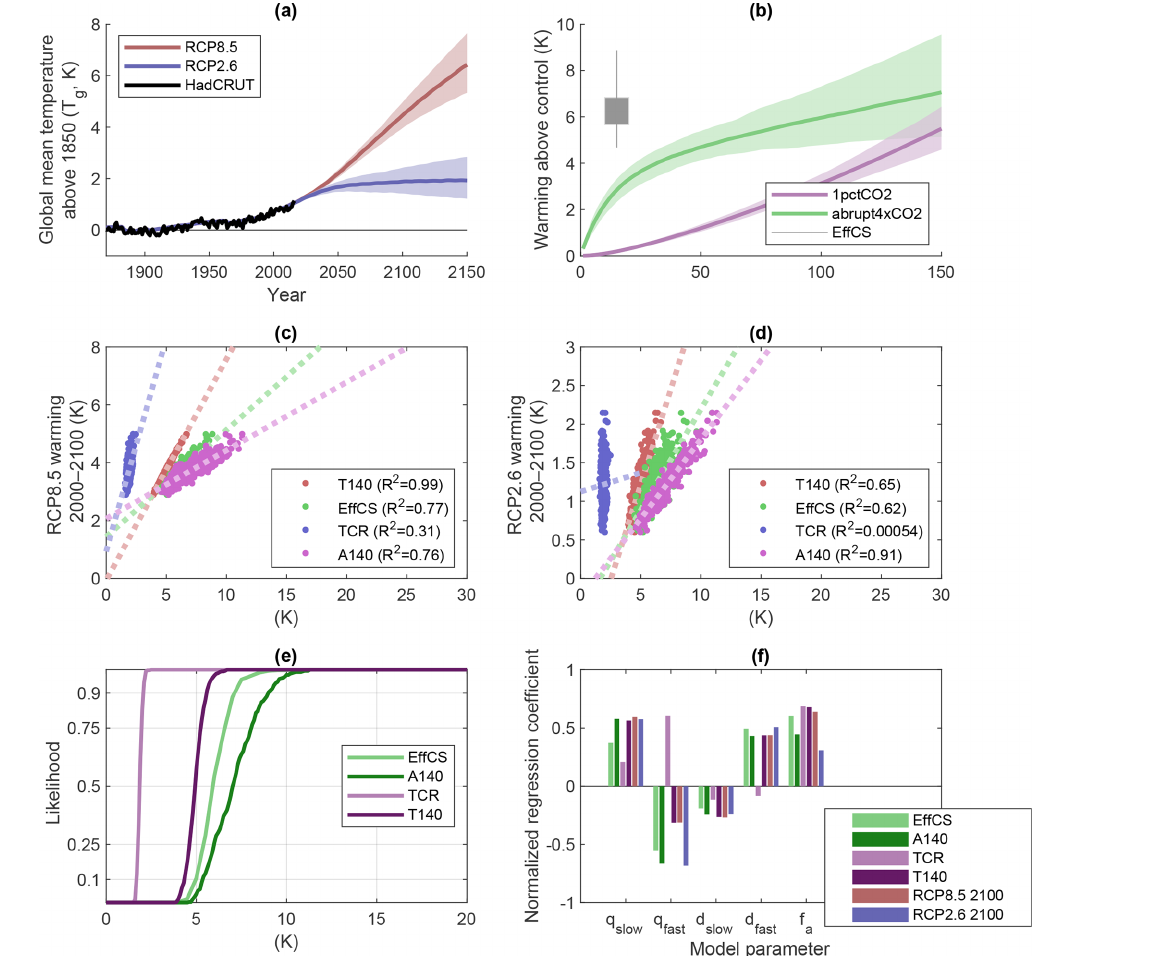
Figure 1. An observationally constrained ensemble of simple models. Panel (a) shows the global mean temperature both historically and under the RCP2.6 and RCP8.5 scenarios. Black lines show the HadCRUT data used in calibration, whereas shaded regions show the 10%– 90% range of scenario projections in the posterior simple model ensemble distribution. Panel (b) shows the corresponding time series posterior distributions for the abrupt4xCO2 and 1pctCO2 simulated experiments, with grey error bars showing range of EffCS for CO 2 quadrupling (boxes and whiskers show 25th–75th and 1st–99th percentiles, respectively). Panels (c, d) show relationships between different sensitivity indicators and 2000–2100 temperature changes under RCP8.5/RCP2.6, respectively; panel (e) shows the posterior cumulative probability density functions for the four sensitivity variables considered; and panel (f) shows the parameter regression coefficients relating the five normalized model input parameters to the four normalized sensitivity